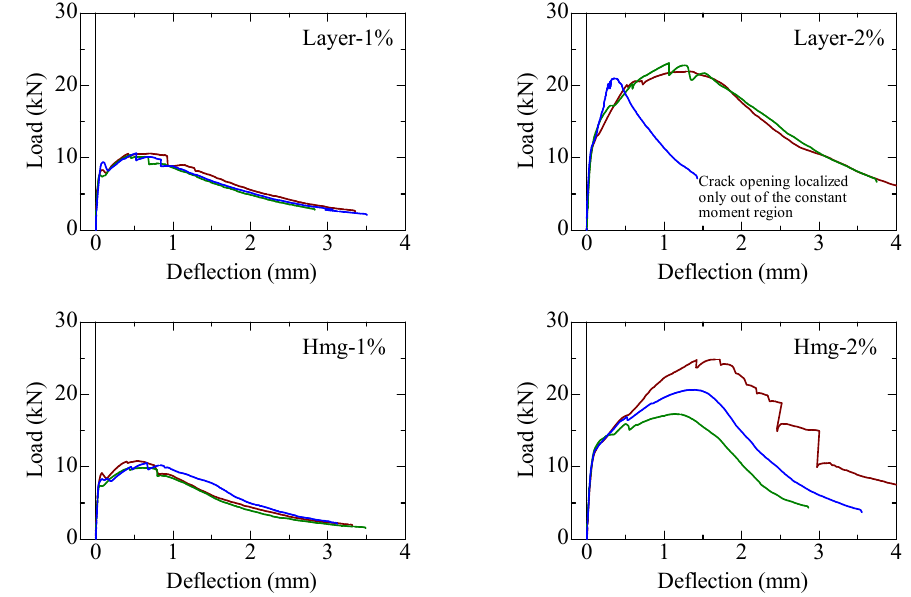
Figure 6. Applied load–deflection curves of 2nd day series specimens.